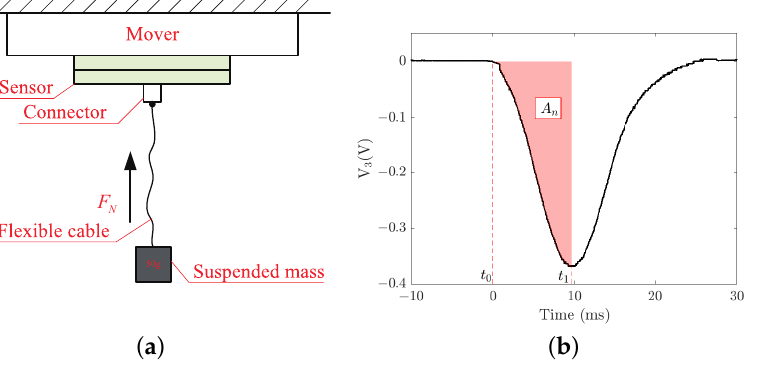
Figure 12. Normal calibration of the sensor: ( a ) schematic diagram of experimental scheme; ( b ) first output voltage waveform of the bottom PZT.